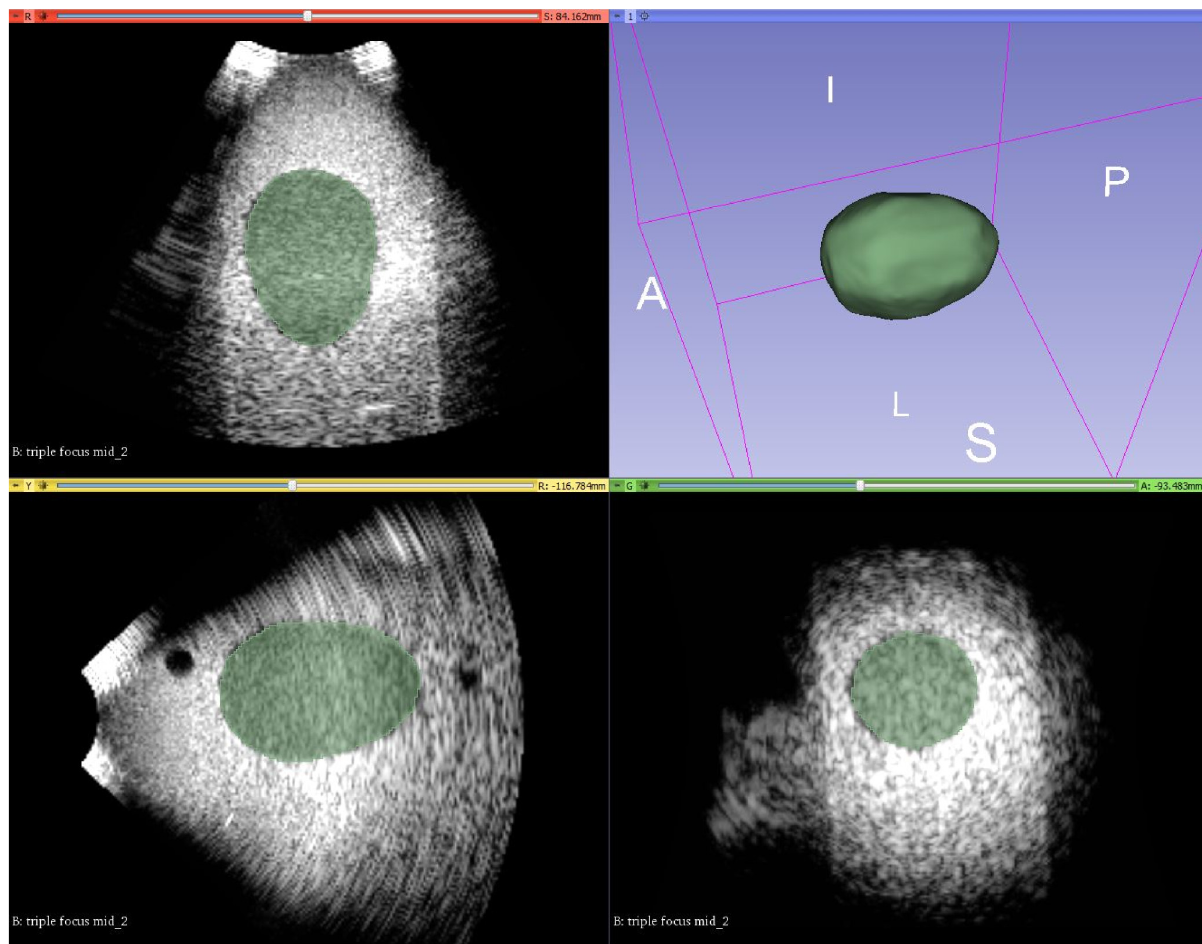
Fig 7. Example 3D mode US image of the egg-phantom in 3D Slicer: The egg-phantom was segmented and the software returned the segmentation result (green) in the xyz planes and in the 3D volume rendering (right top of the image).